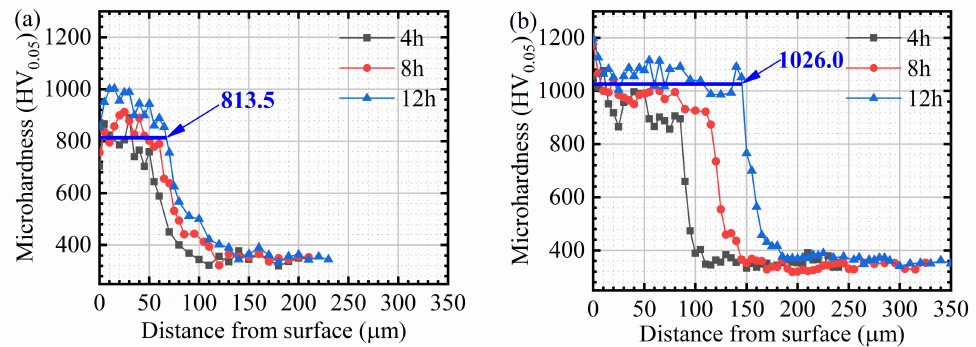
Figure 4. The microhardness diagrams of 3Cr13 steel after plasma nitriding at different times ( a ) Without RE ( b ) With RE.